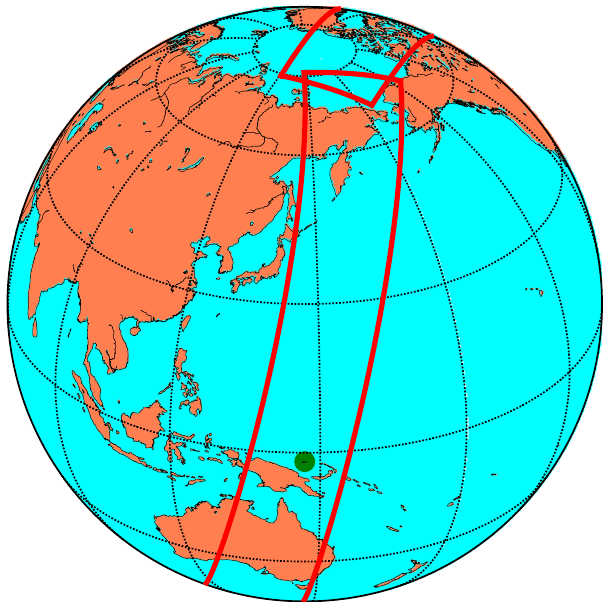
Figure 1. IASI complete orbit (red) on 4 November 2011 at 23:20:57Z over the observatory location, Manus island (green